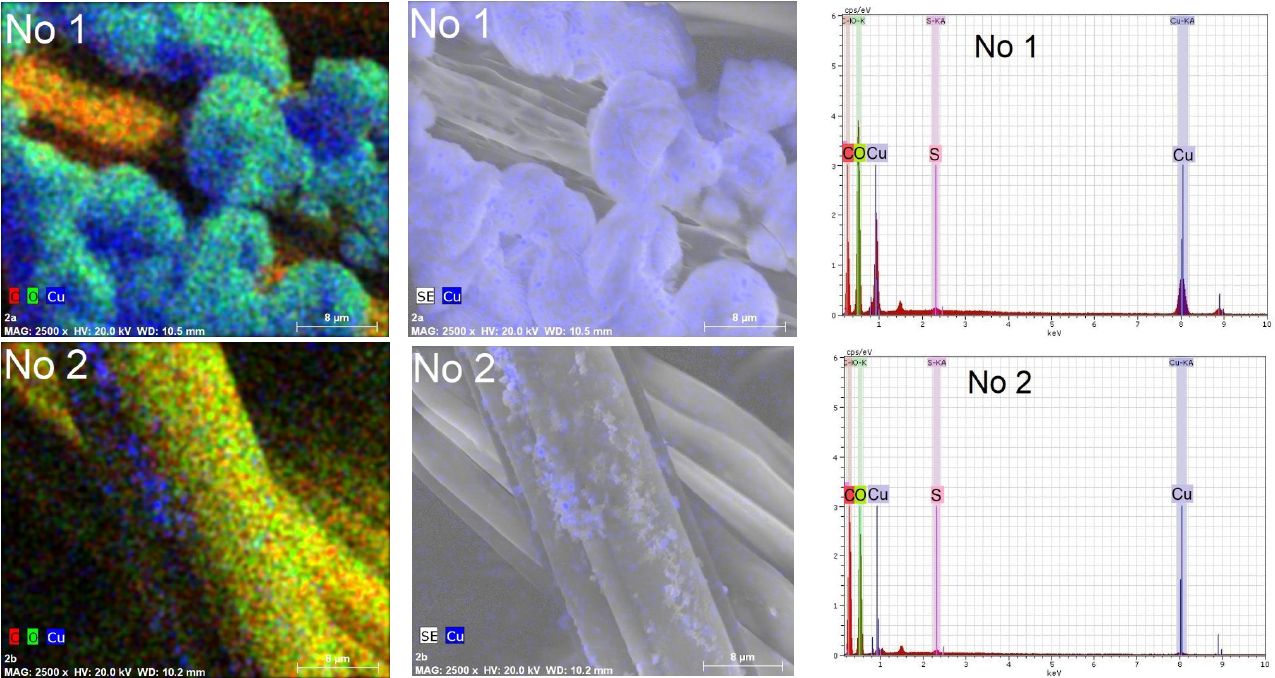
Figure 9. Chemical element maps and EDS spectra of knitted fabric materials sample N4 (PES/viscose, Figure 9 60/40) treated with solutions No. 1 and No. 2. Magnification 2500 ×